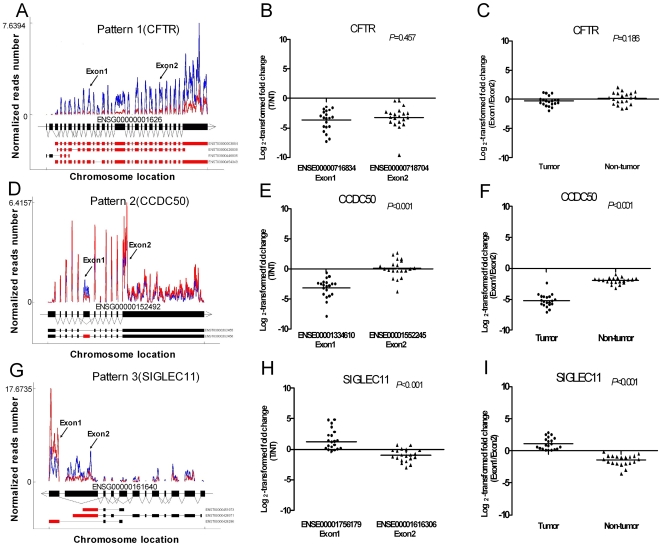
Analysis and validation of DEEs.(A), (D) and (G): Schematic diagrams of 3 representative genes (CFTR, CCDC50, SIGLEC11) illustrating 3 relationship patterns between DEEs and DEGs. The structure of genes, together with all annotated exons and transcripts, were shown at the bottom. The DEEs were highlighted in red on annotated exons of transcripts showing at the bottom. Red curve represents the normalized read counts for HCC tissues and blue curve represents the normalized read counts for adjacent non-cancerous tissues. (B), (E) and (H): Comparison of expression levels of DEEs in three representative genes between HCC and adjacent non-cancerous tissues. (C), (F) and (I): Comparison of expression ratio for different DEEs of the same representative gene in HCC and adjacent non-cancerous tissues. T: tumor NT: Non-tumor.